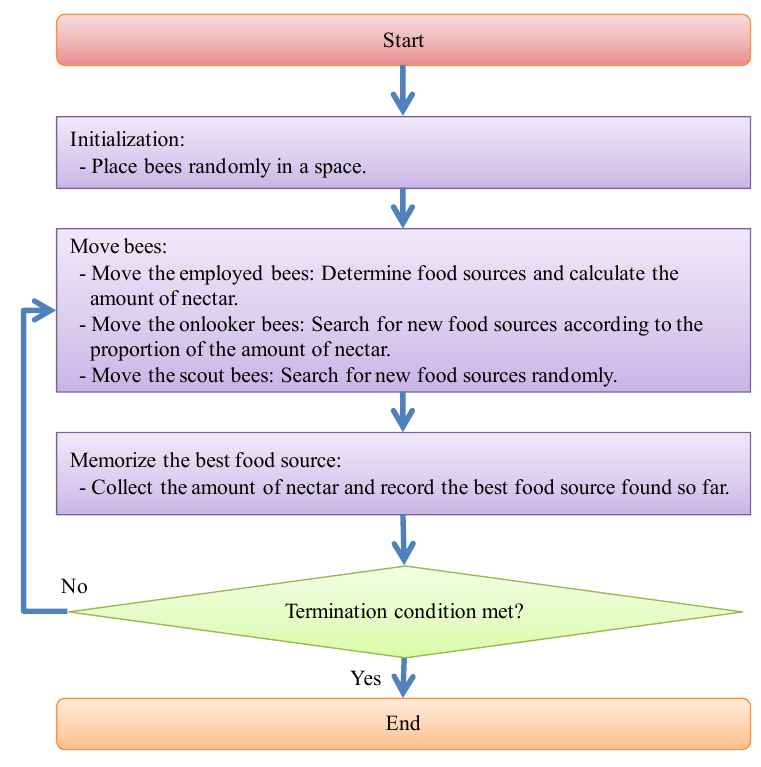
Figure 1. Flow chart of the ABC